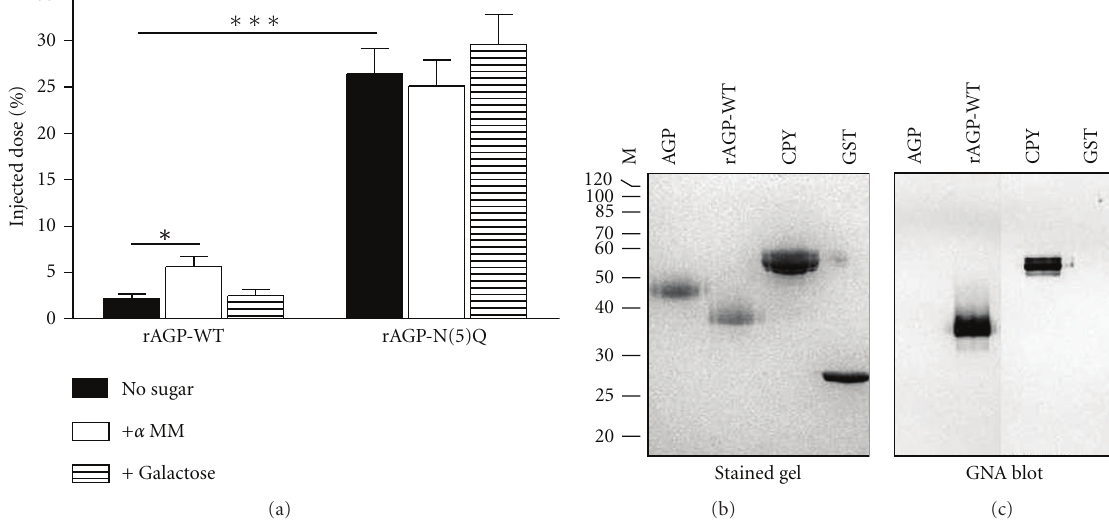
Figure 4: Recombinant AGP glycosylated in Pichia pastoris yeast is rapidly removed from the rabbit circulation via mannose receptors. (a) Shows the radioiodinated rAGP-WT or rAGP N(5)Q remaining in the plasma of rabbits 30 minutes after injection, without (no sugar) or with coadministered α -methylmannoside (+ α MM) or D-galactose (+ Galactose). The mean and SD of 5–7 determinations are shown; ∗ indicates P < 0 . 05 versus the corresponding “no sugar” condition by Kruskal-Wallis test. The proportion of the two proteins remaining in plasma in the absence of added sugar was also compared; ∗∗∗ indicates P < 0 . 001 by unpaired t -test, Welch corrected. (b) (Gel) shows a Coomassie blue-stained 12% SDS reducing gel loaded with 5–10 μ g per lane of AGP (plasma-derived); rAGP-WT; carboxypeptidase Y (CPY); and glutathione sulfotransferase (GST). Molecular mass marker positions, shown at left, correspond to: 100; 90; 80; 70; 60; 50; 40; 30; 25; and 20 kDa. (c) (GNA blot) is a blotted replicate of the gel shown in (b), probed with GNA lectin.